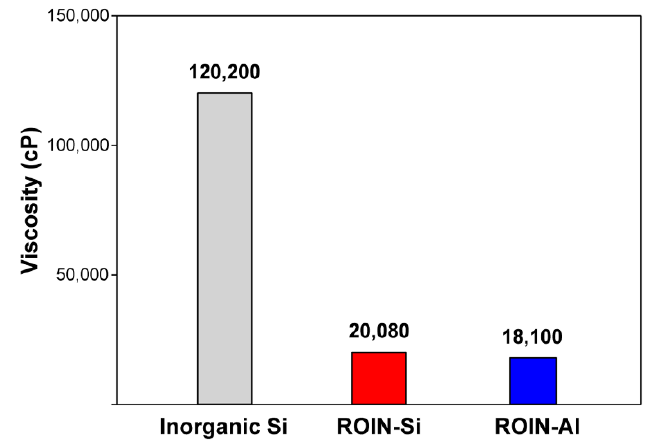
Figure 5. Viscosities of conventional sealing composite with inorganic Si and new epoxy–acrylate composites with ROIN-Si and ROIN-Al nanoparticles.